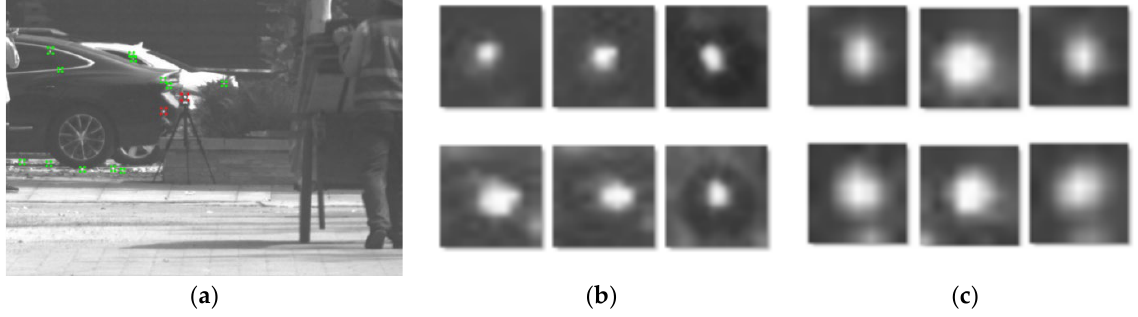
Figure 2. Sample images of a partial dataset. ( a ) Active image labeled with a true target in the dataset, ( b ) part of the true target dataset, and ( c ) part of the false target dataset.